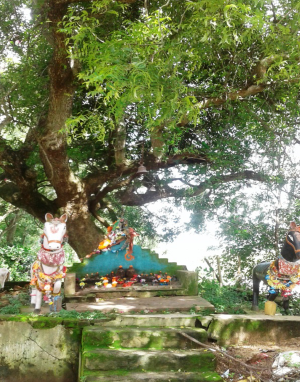
Figure 1. Neem tree with village deity